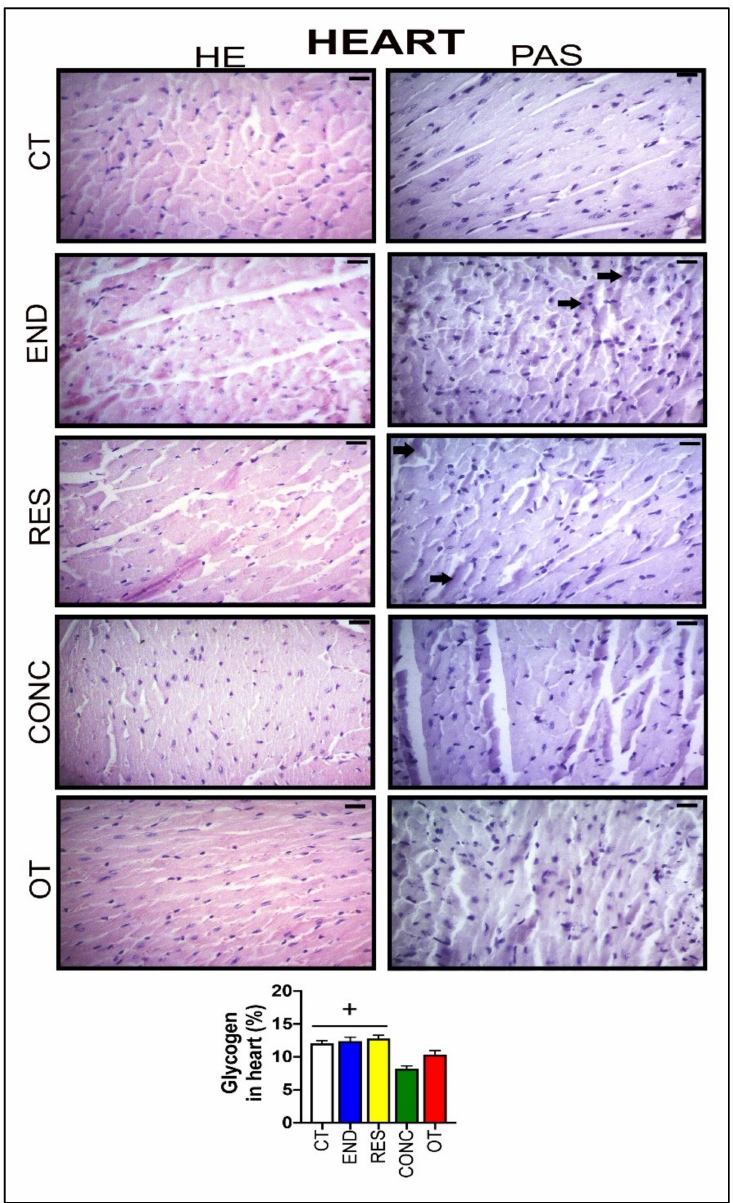
Figure 6. Histological characterization ( × 400) of heart by hematoxylin-eosin (HE) and periodic acid Schi ff (PAS) and, glycogen contents in the heart. Bar = 20 µ m. Data correspond to the mean ± SEM of 4–5 mice / group. Glycogen granules ( ). + p ≤ 0.05 vs. CONC. (Sedentary; control group); END (Endurance; submitted to the chronic endurance exercise protocol); RES (Resistance; submitted to the chronic resistance exercise protocol); CONC (Concurrent; submitted to the chronic concurrent exercise protocol); OT (Overtraining; submitted to the chronic exhaustive exercise